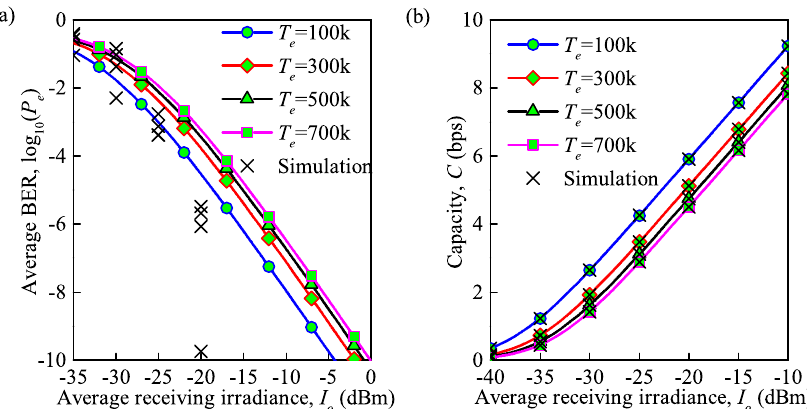
Figure 7. ( a ) Average BER at different temperatures under the influence of thermal noise; ( b ) average capacity at different temperatures under the influence of thermal noise ( C 2 n = 0.75 × 10 − 14 m − 2/3 for moderate turbulence, λ = 850 nm, R b = 0.155